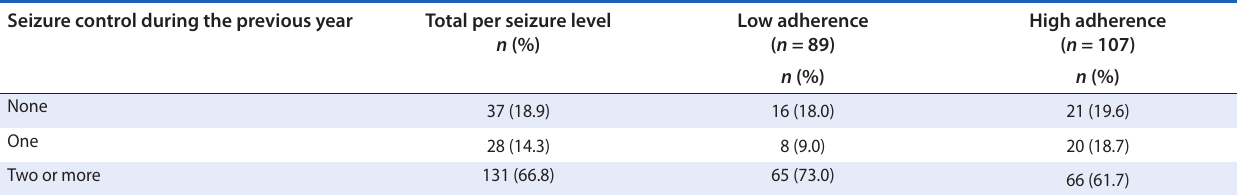
Table 3: Seizures by MMAS-8 adherence ( n = 196) Seizure control during the previous